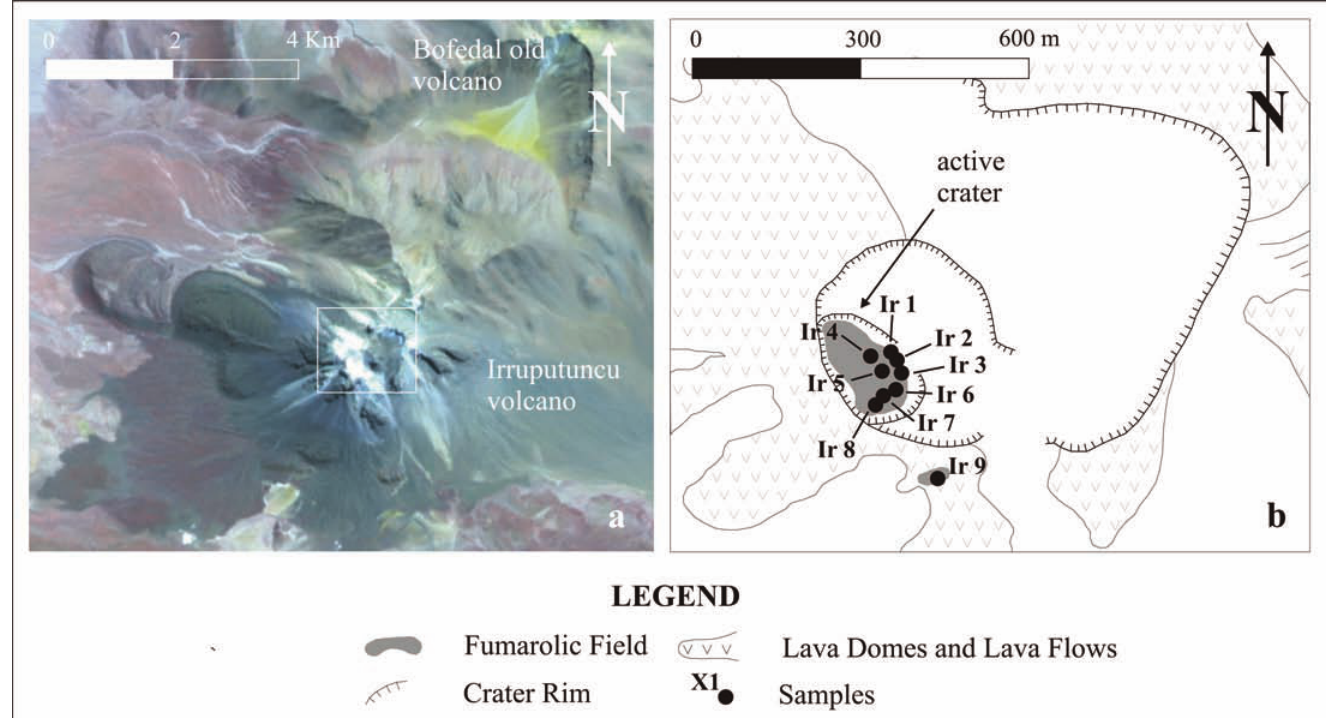
Figure 2. Aerial photograph (a) and schematic map (b) of the summit crater of Irruputuncu volcano, showing the locations of the fumarolic fields and sampling sites.